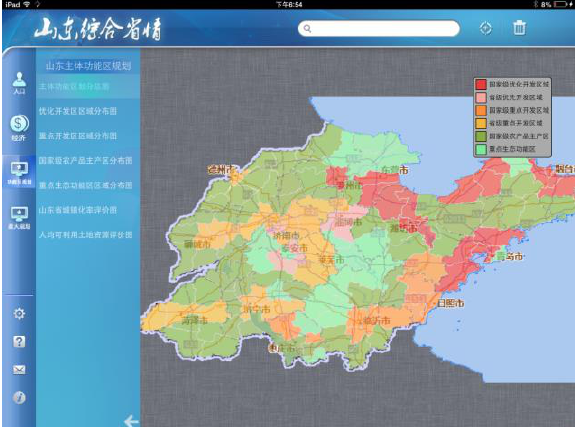
Figure 5. The Map of Main Functional Areas Division of Shandong